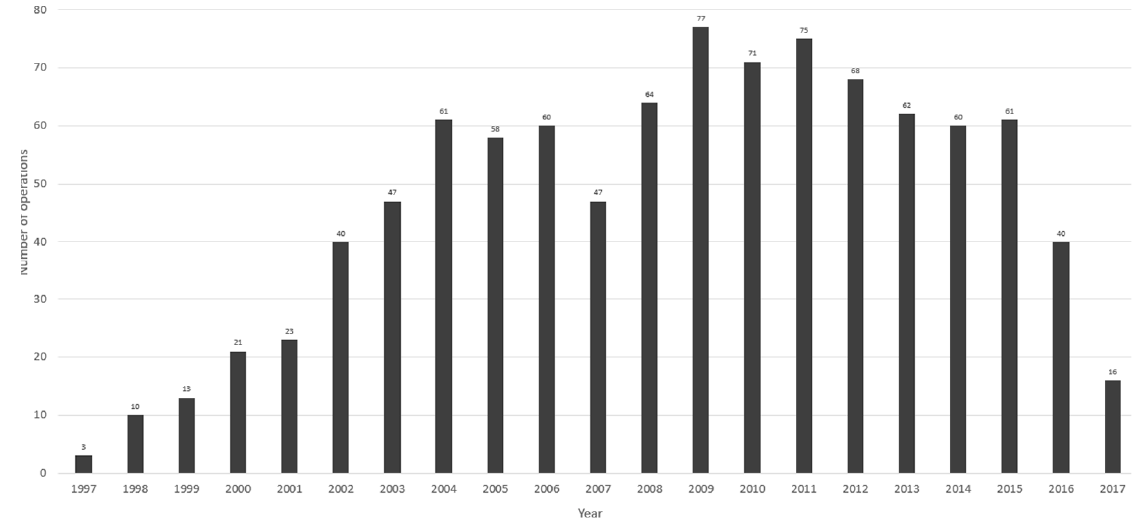
Figure 1. Annual number of operations.